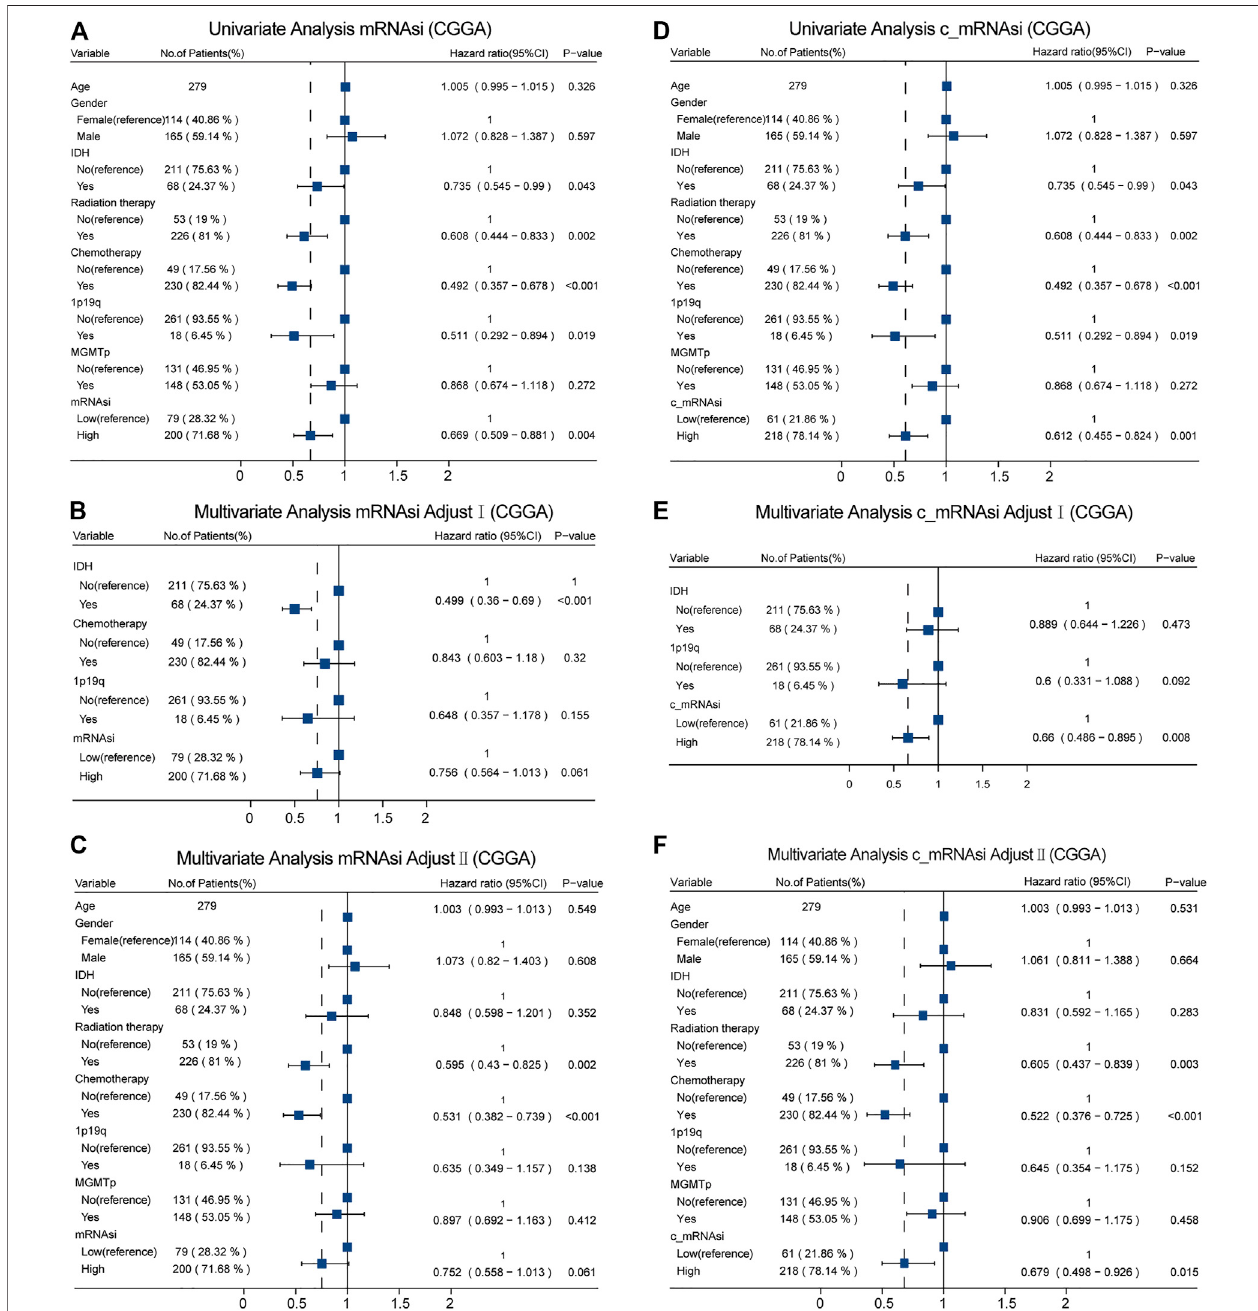
FIGURE 4 | Forest plots of univariate and multivariate Cox regression analysis in CGGA. (A) . Univariate Cox regression analysis of mRNAsi in CGGA. (B) . MultivariateCoxregressionanalysisofmRNAsiadjustedImodelinCGGA. (C) .MultivariateCoxregressionanalysisofmRNAsiadjustedIImodelinCGGA. (D) .Univariate Cox regression analysis of c_mRNAsi in CGGA. (E) . Multivariate Cox regression analysis of c_mRNAsi adjusted I model in CGGA. (F) . Multivariate Cox regression analysis of c_mRNAsi adjusted II model in CGGA.